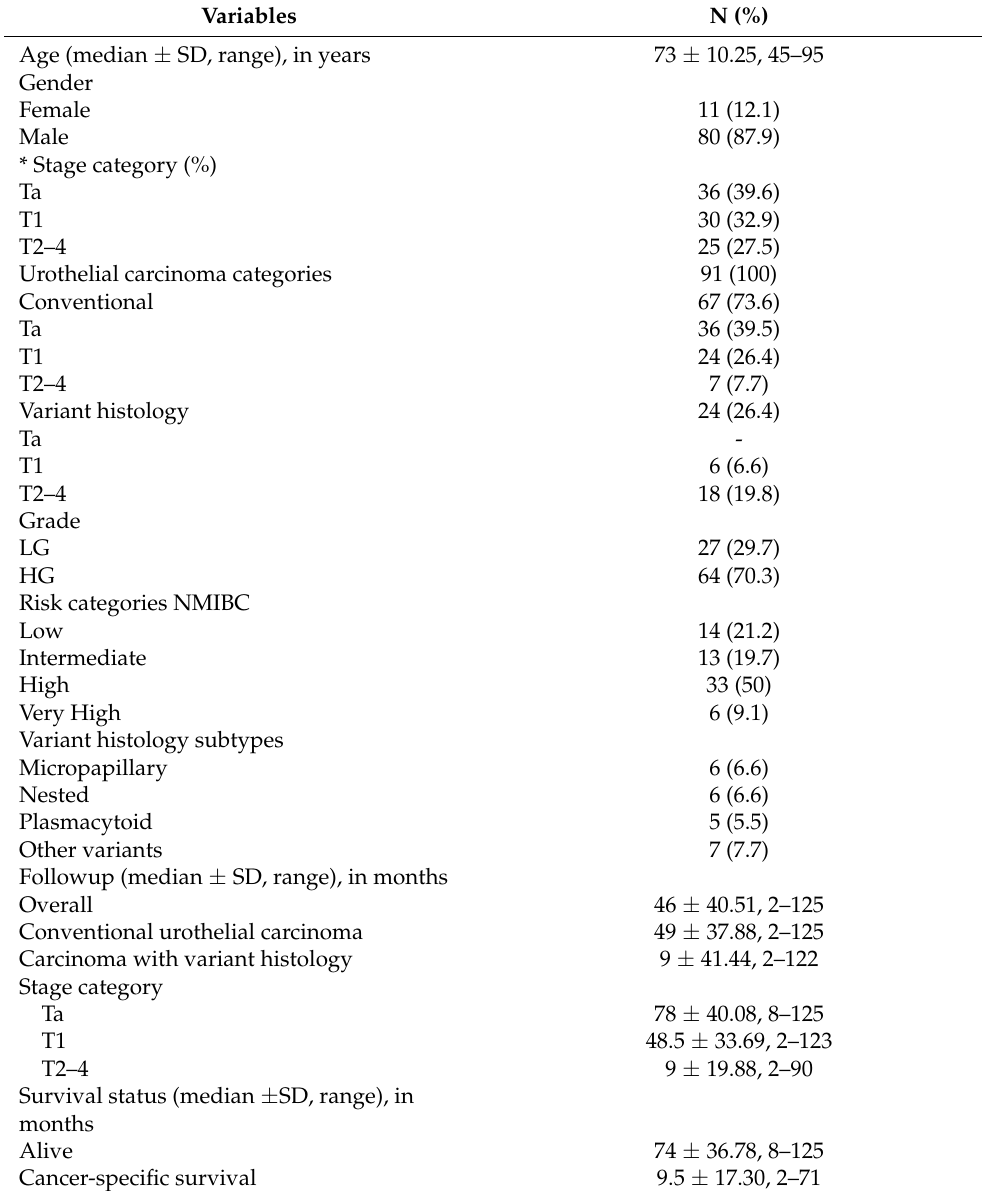
Table 1. Demography and clinicopathological characteristics of 91 bladder urothelial carcinomas included in the